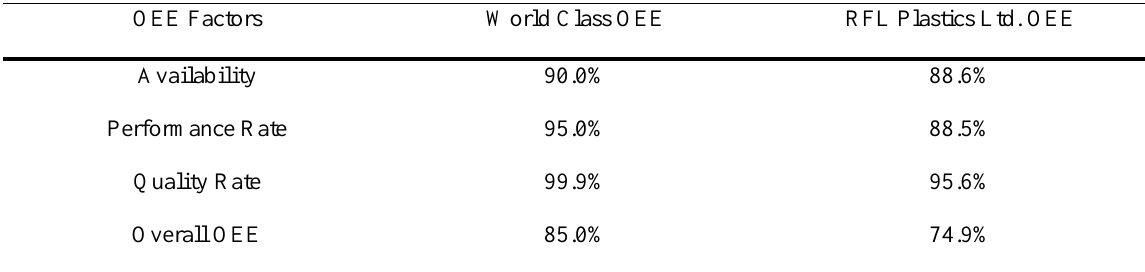
Table 5. Comparison between world OEE and RFL’s OEE (4